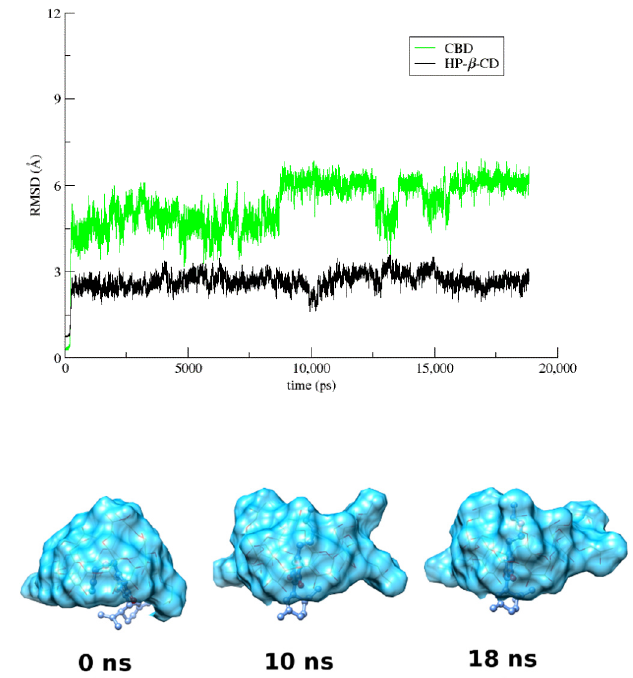
Figure 7. RMSD from the first frame of the trajectory for encapsulated CBD (green) in HP- β -CD (black) as a function of MD simulation time and representative snapshots of CBD/HP- β -CD inclusion complex at 0, 10, and 18 ns. Table 3. Binding free energies and their standard deviations (kcal/mole) resulting from MM/GBSA analysis of the inclusion compounds of CBD/DM- β -CD (1:1), CBD/TM- β -CD dimer (2:1), and CBD/HP- β -CD